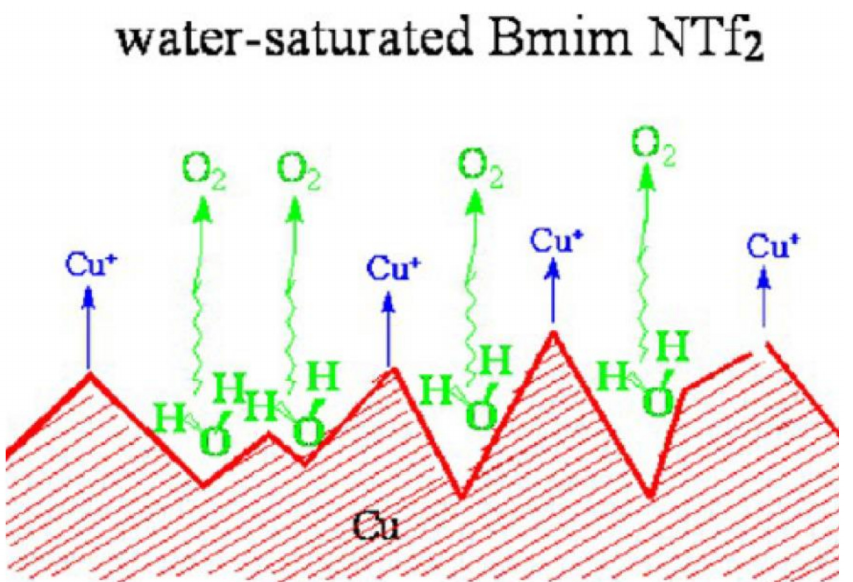
Figure 9. The mechanism of copper electropolishing in water-saturated hydrophobic BmimNTf 2 IL (reprinted with permission from ref. [15]; Copyright 2013 American Chemical